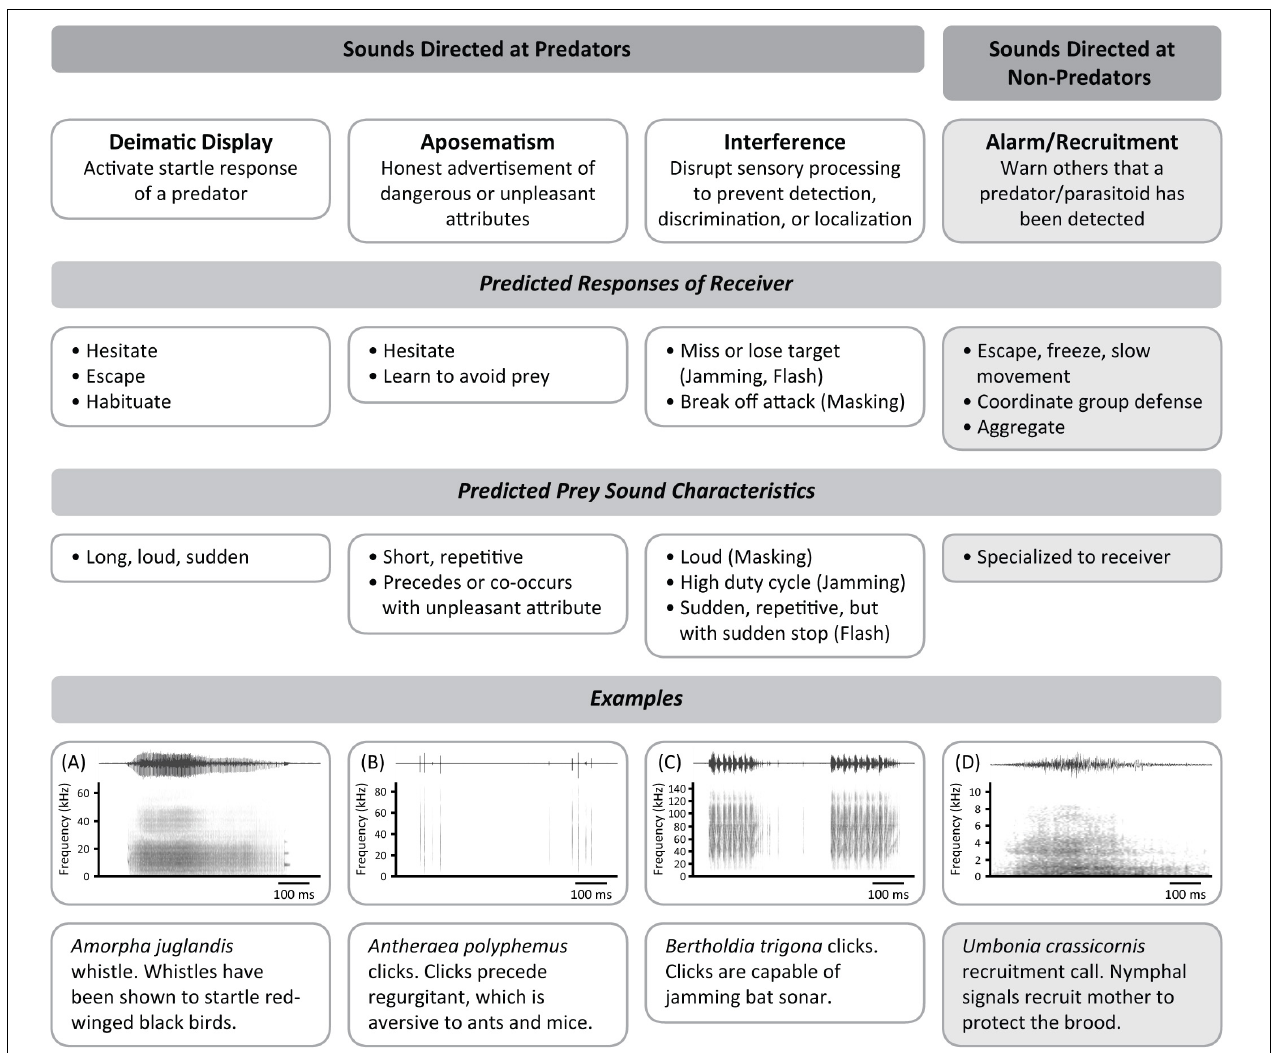
FIGURE 5 | Hypotheses explaining the function of insect defense sounds with corresponding predictions of both prey characteristics and receiver responses. Sound files (A–D) , shown as examples, were contributed by the Yack Lab ( A. juglandis and A. polyphemus ), A. Corcoran ( B. trigona ), and R. Cocroft ( Umbonia crassicornis ). See text for further discussion of these functions and corresponding